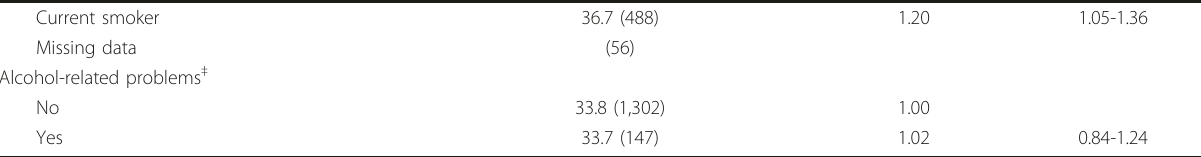
Table 2 First hospitalization rates and adjusted odds ratios for active-duty military personnel over a 1-year period enrolled in the Millennium Cohort Study 2004-2006 ( N = 42896)* (Continued)